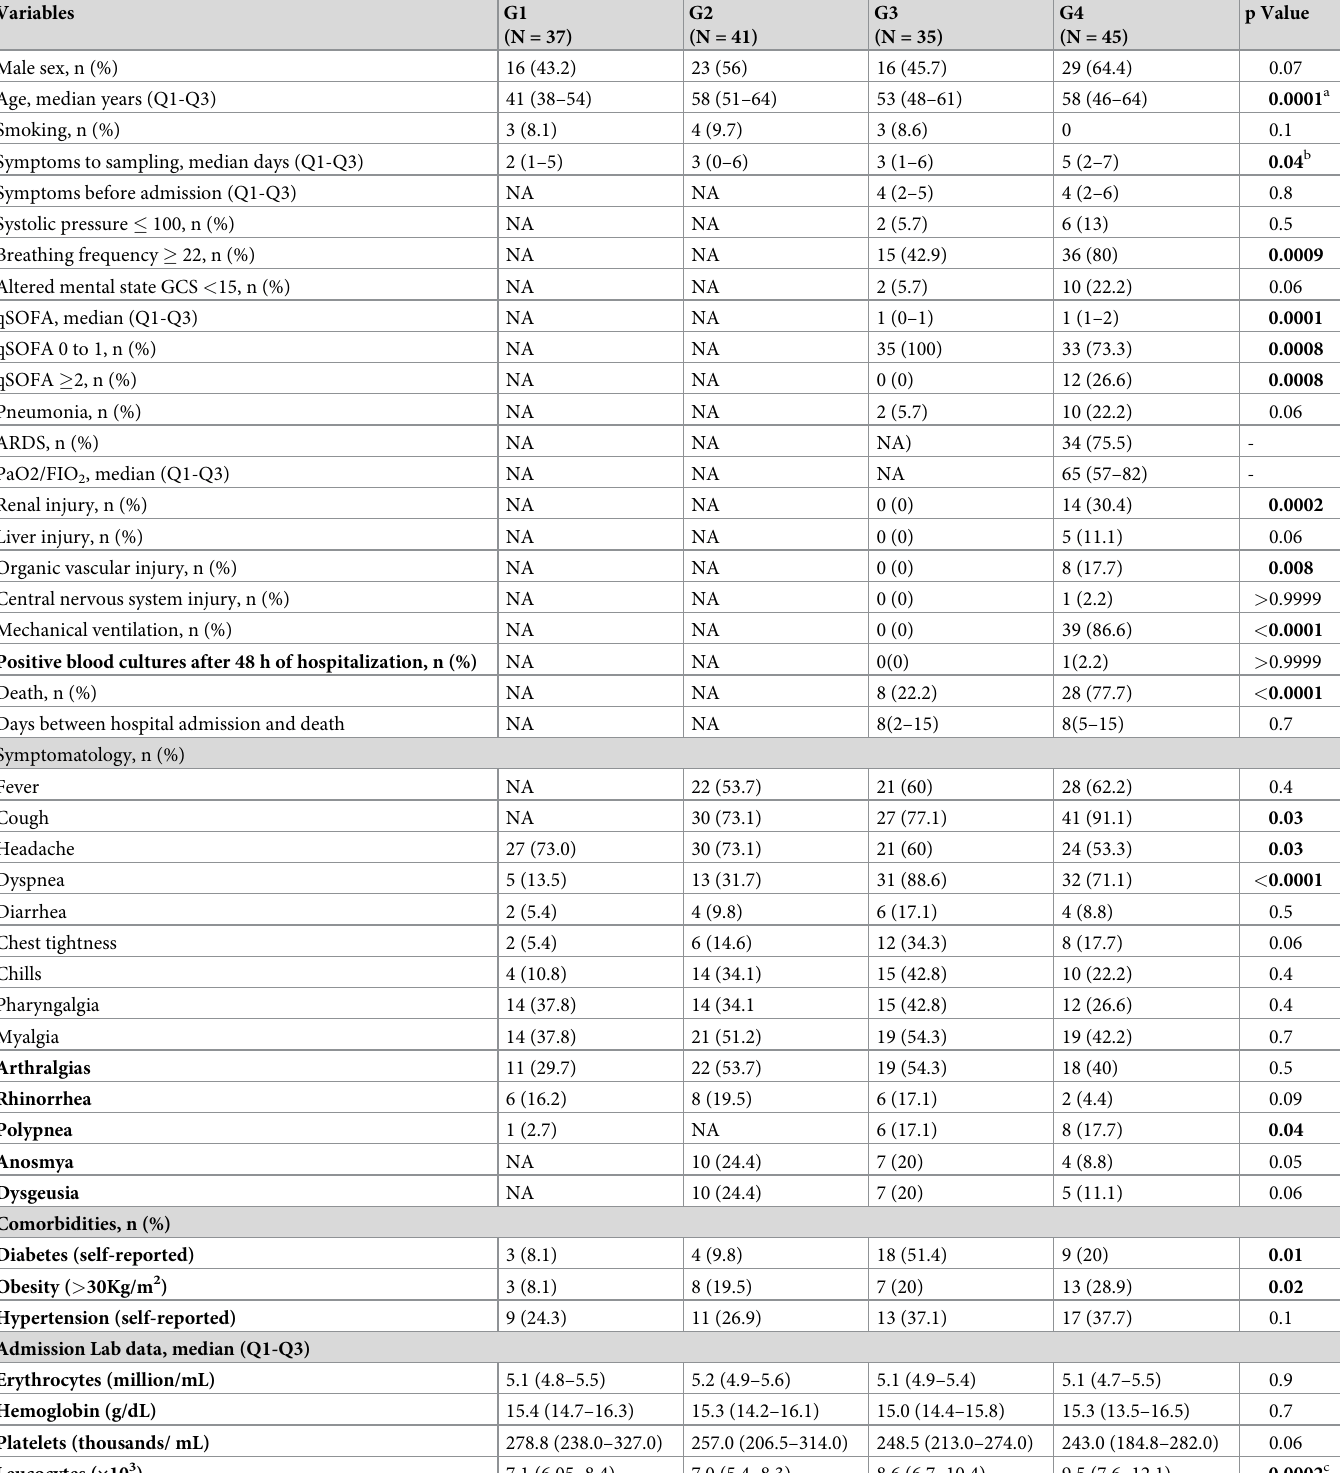
Table 1. Sociodemographic, epidemiological, and clinical characteristics, including laboratory analyses, of the study participants by surveyed